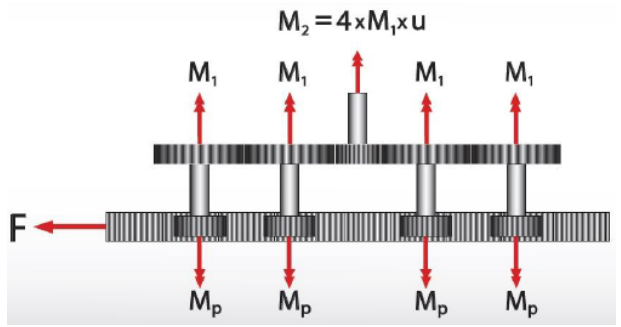
Figure 14. Gearbox ratio analysis [101]. A generous contribution by David Albady.